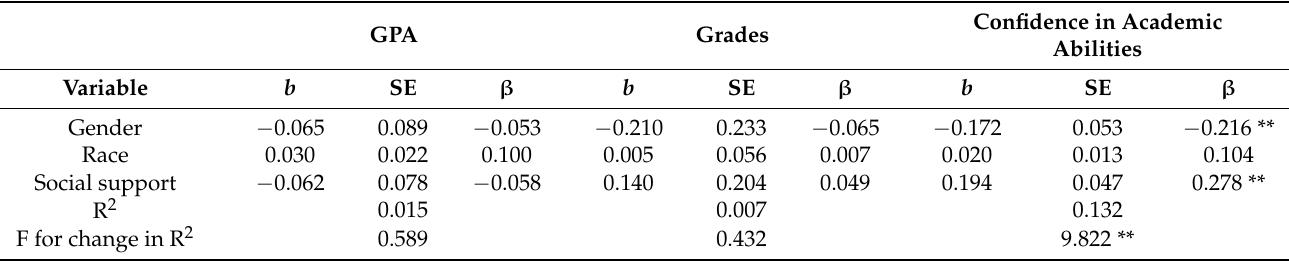
Table 2. Summary of regression analyses for the association between social support and academic outcomes. GPA Grades